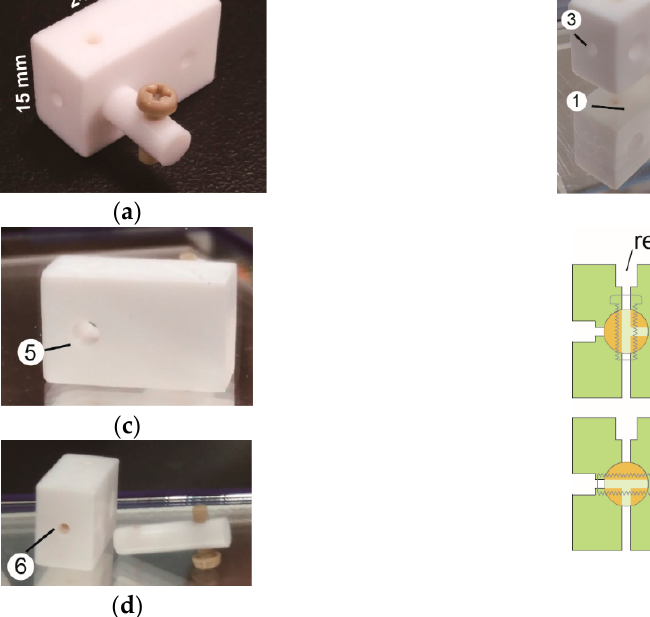
Figure 1. DK1 port for microfluidic protein chip. ( a ) The port is equipped with a three-way switch. ( b) The bottom ( ○ 1 ), front ( ○ 2 ), left side ( ○ 3 ), and top ( ○ 4 ) views of a disassembled DK port with the rod ( ○ R ) of the three-way switch. Three red arrows indicate the openings of T-shaped tunnels. ( c ) and ( d ) The back ( ○ 5 ) and right side ( ○ 6 ) views of the disassembled DK port. Mirrors were placed below and around the parts to show all sides of the port. ( e ) The cross-section views of the DK1 port showing the positions of the three-way switch for the ‘top-only’ (upper panel) and the ‘side-only’ (lower panel) entries of fluids.